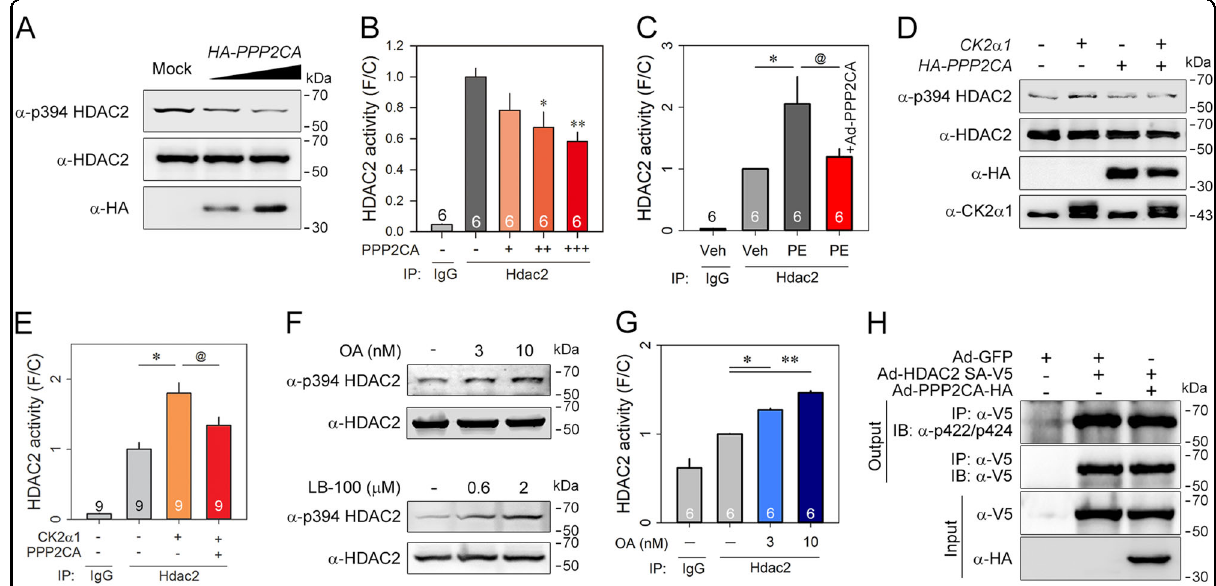
Fig. 2 PPP2CA speci fi cally regulates both HDAC2 phosphorylation and subsequent activation. a PPP2CA reduced HDAC2 S394 phosphorylation. HDAC2 phosphorylation was decreased in a PPP2CA-HA dose-dependent manner in H9c2 cells, a cardiomyoblast cell line. b The intrinsic activity of HDAC2 was decreased in a PPP2CA dose-dependent fashion. c Adenovirus expressing PPP2CA (Ad-PPP2CA) abridged HDAC2 hyperactivation induced by treatment with 20 μ mol/L phenylephrine (PE), an alpha-adrenergic agonist, in NRVCs. PE-induced enzymatic activation of HDAC2 was signi fi cantly diminished by simultaneous infection of PPP2CA. The changes were displayed as the fold change by dividing by the mean value of the control group. PPP2CA attenuated HDAC2 phosphorylation and thereby activation induced by CK2 α 1. d , e CK2 α 1-induced HDAC2 phosphorylation ( d , 2nd lane) and HDAC2 activation ( e , 2nd bar) were completely blocked by co-transfection of PPP2CA ( e , 4th lane, and e , 4th bar) in H9c2 cells. Okadaic acid (OA), a selective PP2A inhibitor, induced an increase in phosphorylation ( f , upper panel) and intrinsic activity ( g ) of HDAC2. LB-100, an alternate PP2A inhibitor, also induced HDAC2 S394 phosphorylation ( f , lower panel). h PPP2CA speci fi cally regulated S394 phosphorylation of HDAC2. PPP2CA failed to reduce phosphorylation of S422 and S424 phosphorylation in the HDAC2 S394A mutant. The designated number in ( b ) and ( c ) indicated an independent experimental set. Data are presented as the mean ± SEM. * and @ indicate p < 0.05. In case of ** p <